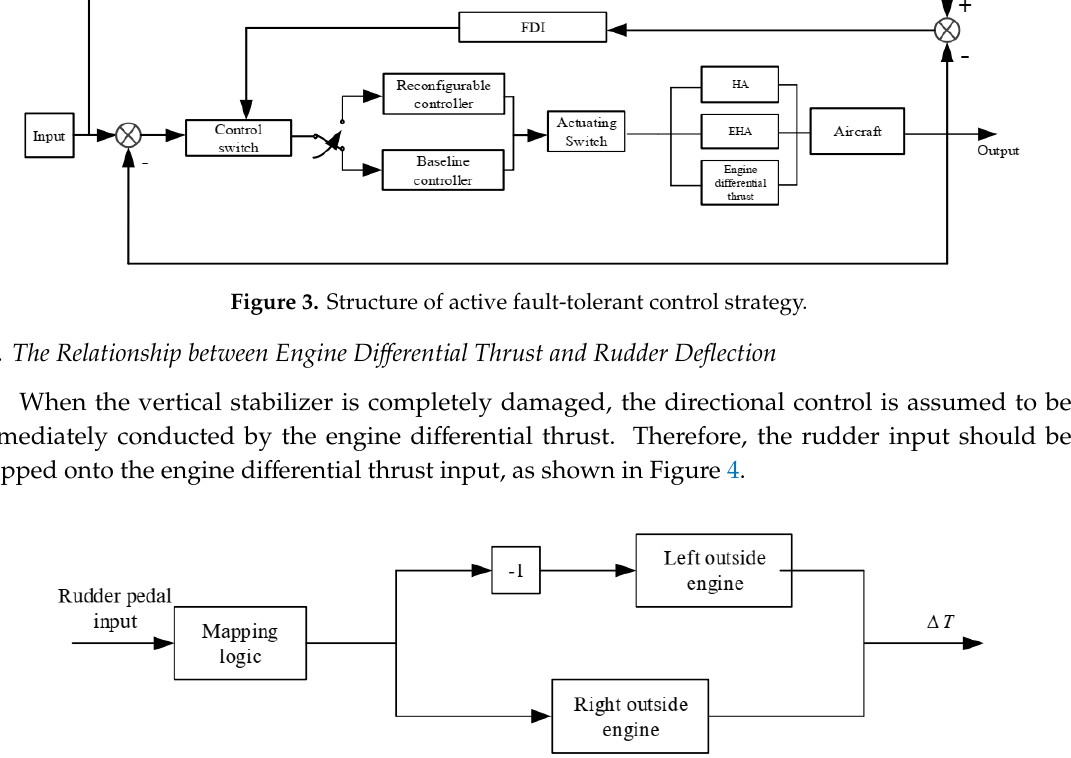
Figure 4. Conversion from rudder input to di ff erential